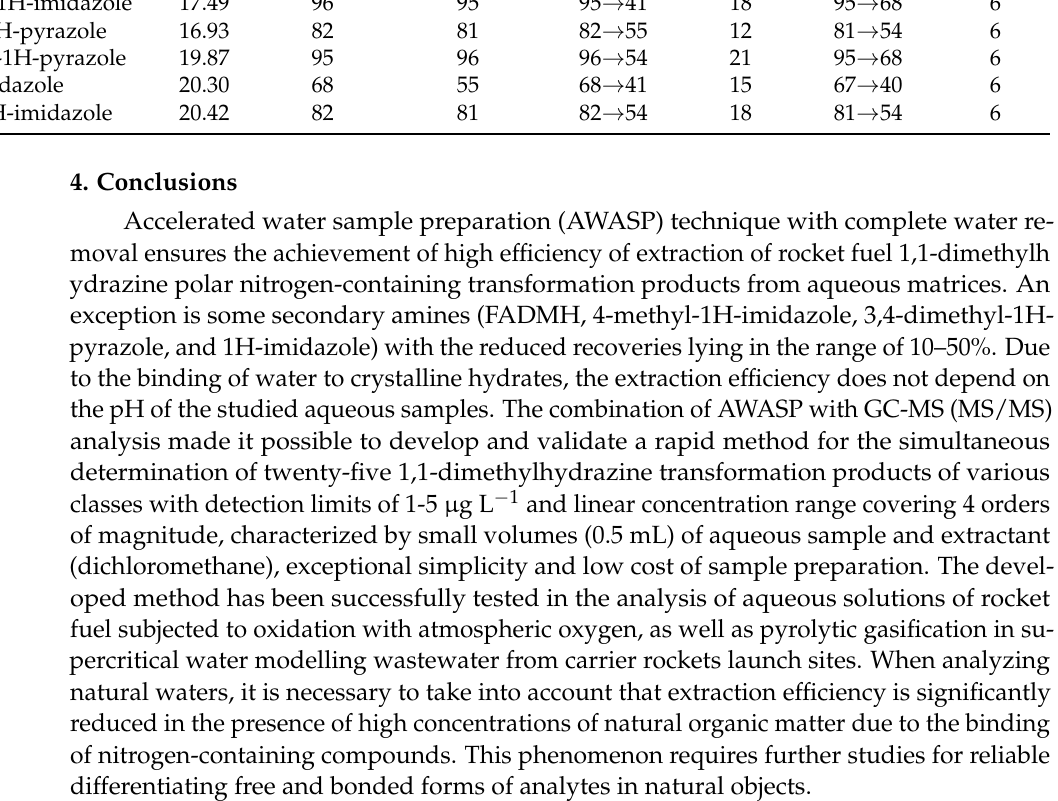
Supplementary Materials: The following are available online, Figure S1: Comparison of the analyte recoveries in AWASP at aqueous phase pH 5 and 12 (extractant—dichloromethane, dehydrating target analytes (peak numbers correspond to compound numbers in tables), Table S1: List of analytes and their physico-chemical properties, Table S2: Accuracy of the developed AWASP-GC-MS method